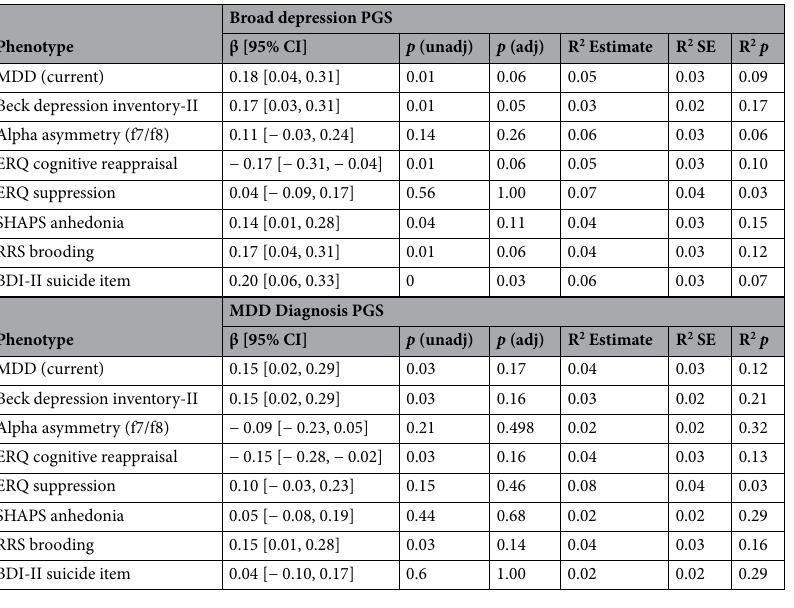
Table 2. Polygenic scores (PGS) effect on depression relevant outcomes. ERQ emotion regulation questionnaire, SHAPS Snaith–Hamilton pleasure scale, RRS ruminative response scale. p(unadj) is the observed two-tailed, p-value uncorrected for multiple testing with correlated outcomes. p(adj) refers to the false discovery rate adjusted p-value for correlated